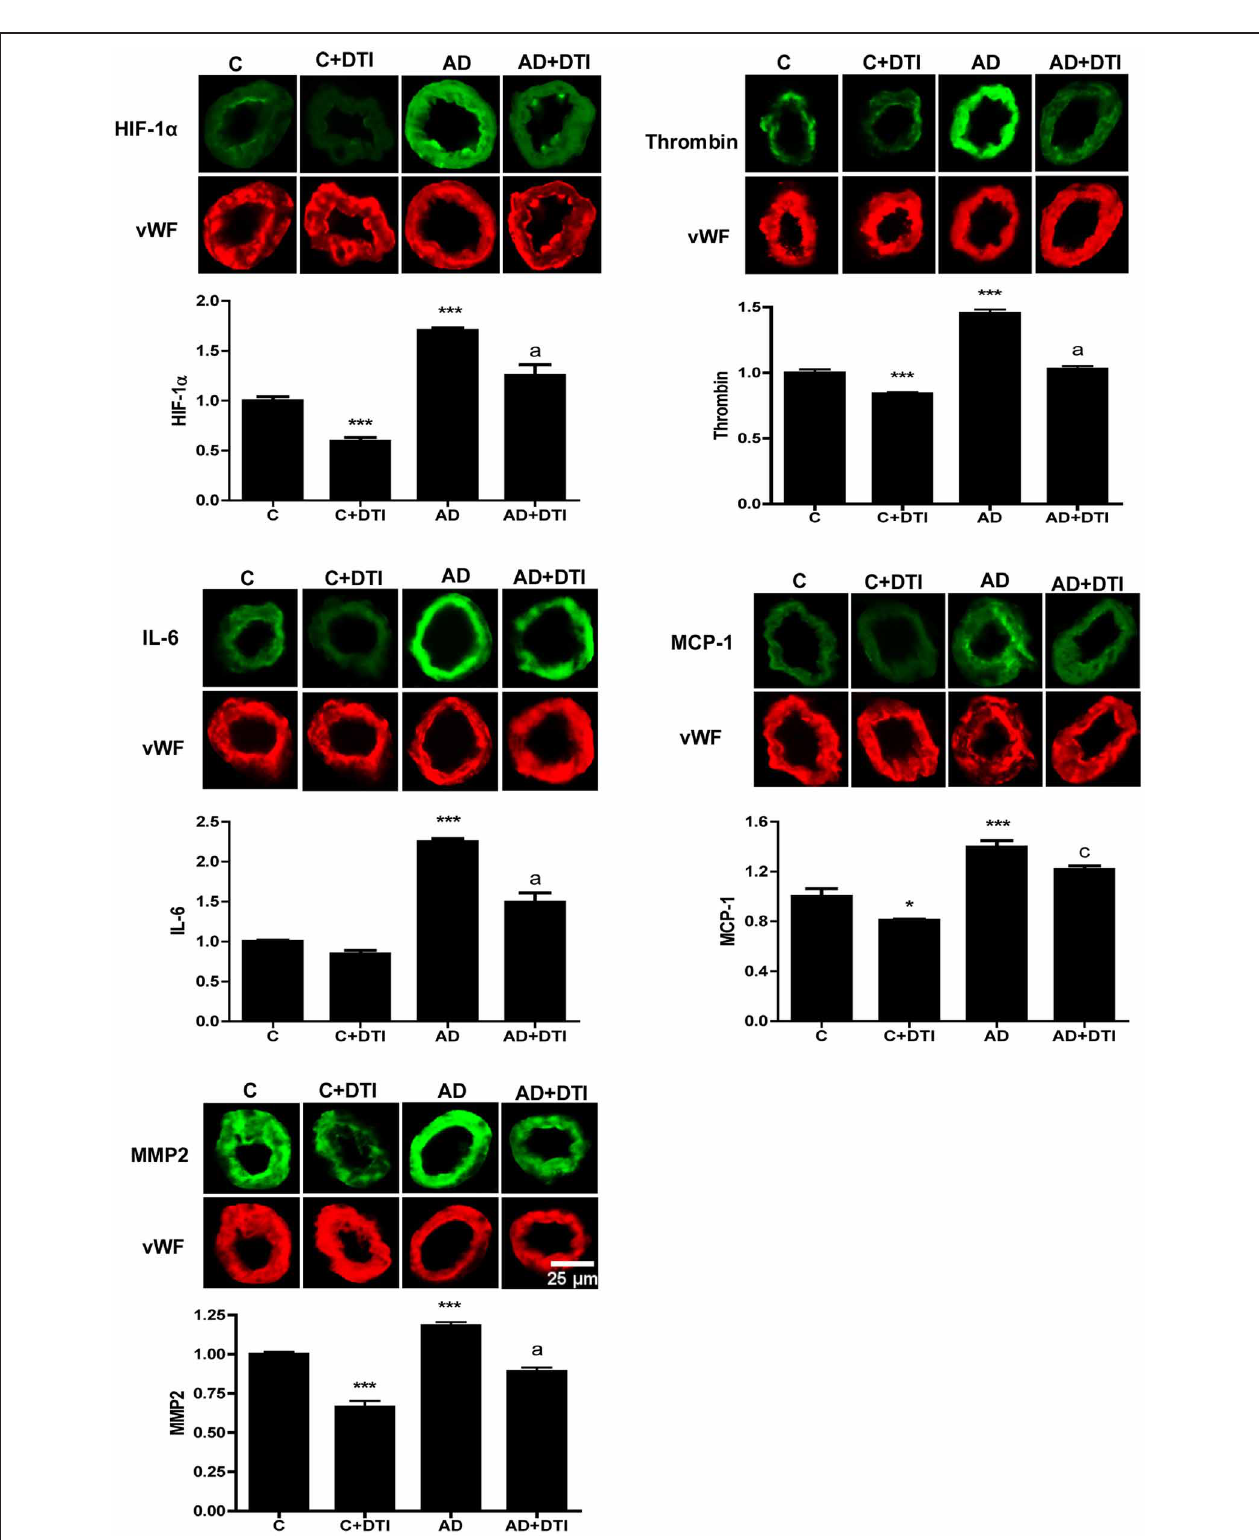
FIGURE 2 | Brain tissues from control, control + DTI, AD and AD + DTI AD mice were fixed and immunostained with HIF-1 α , thrombin, IL-6, MCP-1, and MMP2 primary antibodies and fluorescence labeled secondary antibody (green). The bar graph